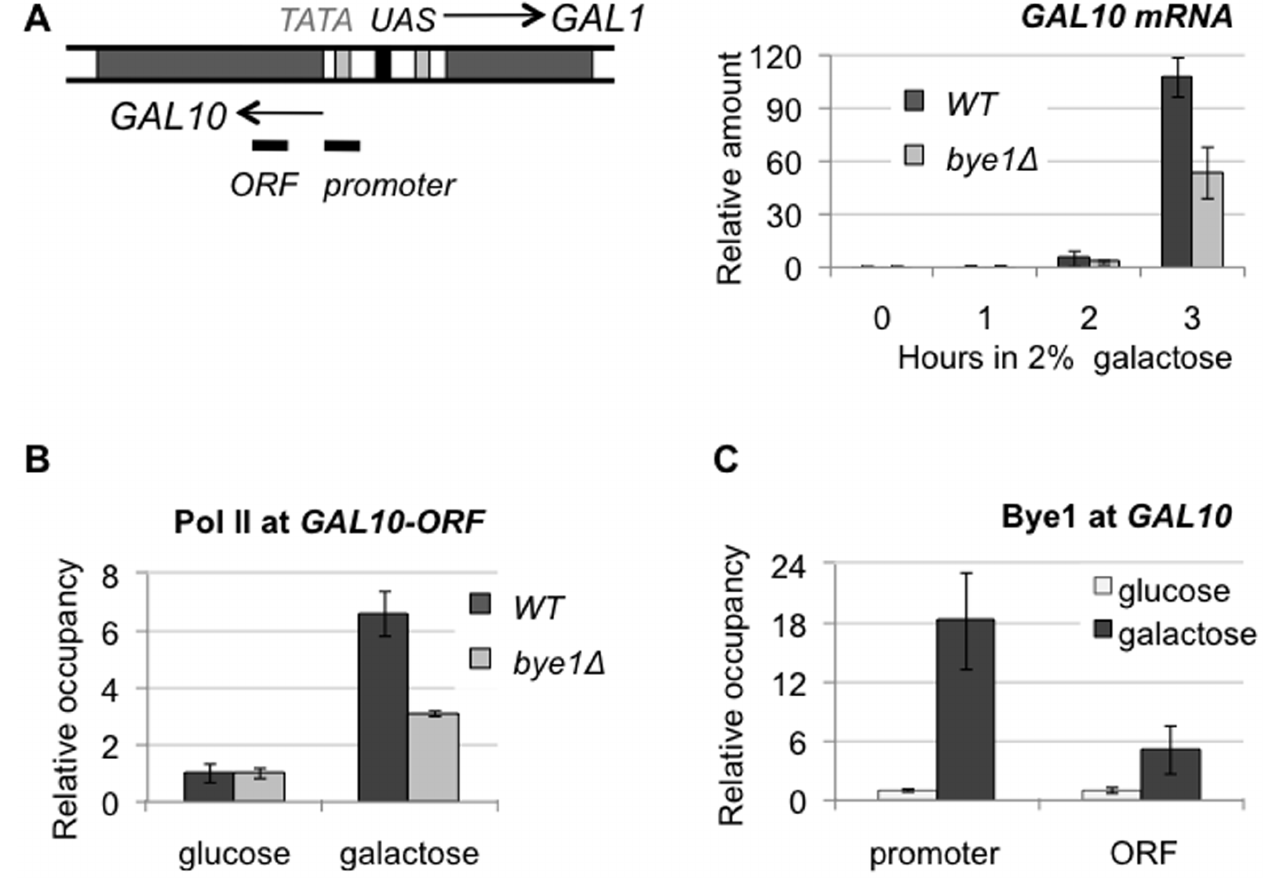
Figure 6. Bye1 positively regulates the GAL10 gene transcription: (A) GAL10 steady-state mRNA levels measured by RT-qPCR in WT and bye1 D strains grown in a glucose- or galactose-supplemented medium; (B) Quantification of Rpb1 occupancy of GAL10 in glucose and after 3 hours of induction in galactose media in WT and bye1 D strains by ChIP; (C) Quantification of Bye1-Myc occupancy of promoter and coding regions of GAL10 relative to RPO21- ORF under repressed (in glucose) and activated (in galactose) conditions by ChIP.